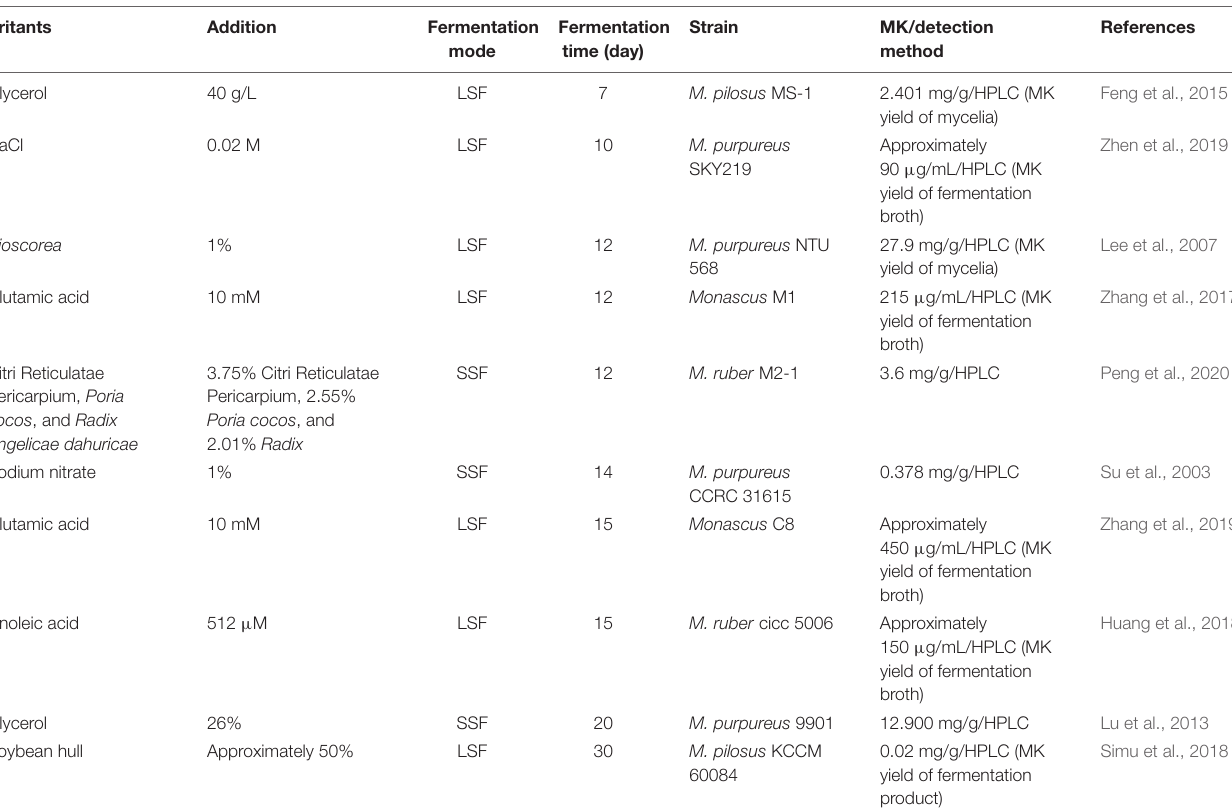
TABLE 2 | Irritants used for improving MK